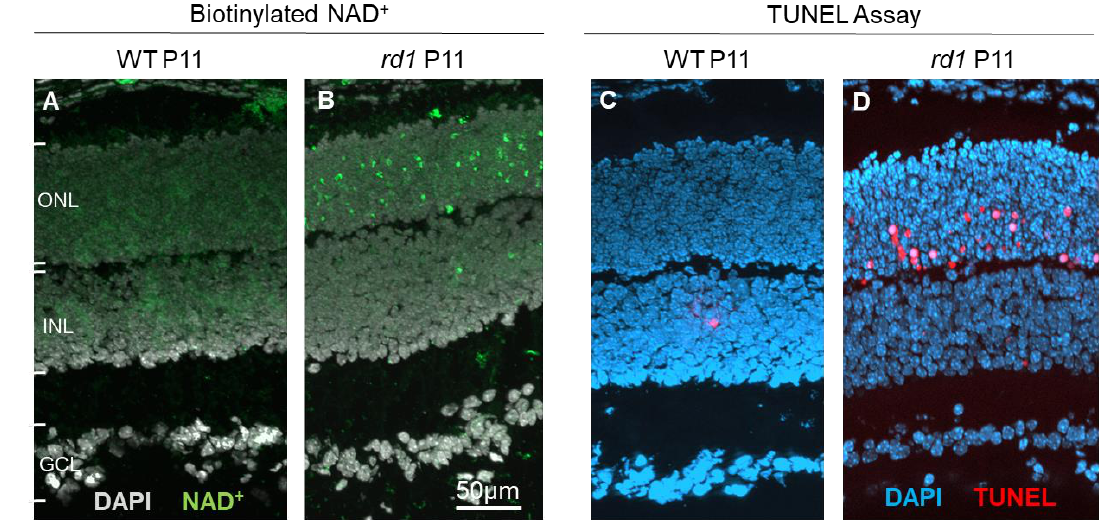
Figure 4. Incorporation of NAD + as a biomarker for retinal cell death. At post-natal day 11 (P11), when compared to wild-type (WT) retina ( A ), photoreceptors in the rd1 mouse model ( B ) display marked incorporation of biotinylated NAD + . This is highly correlated with the TUNEL assay for cell death, which at the same age detects only few cells in the WT situation ( C ), while large numbers are detected in the rd1 outer nuclear layer (ONL; D ). INL = inner nuclear layer, GCL = ganglion cell layer.